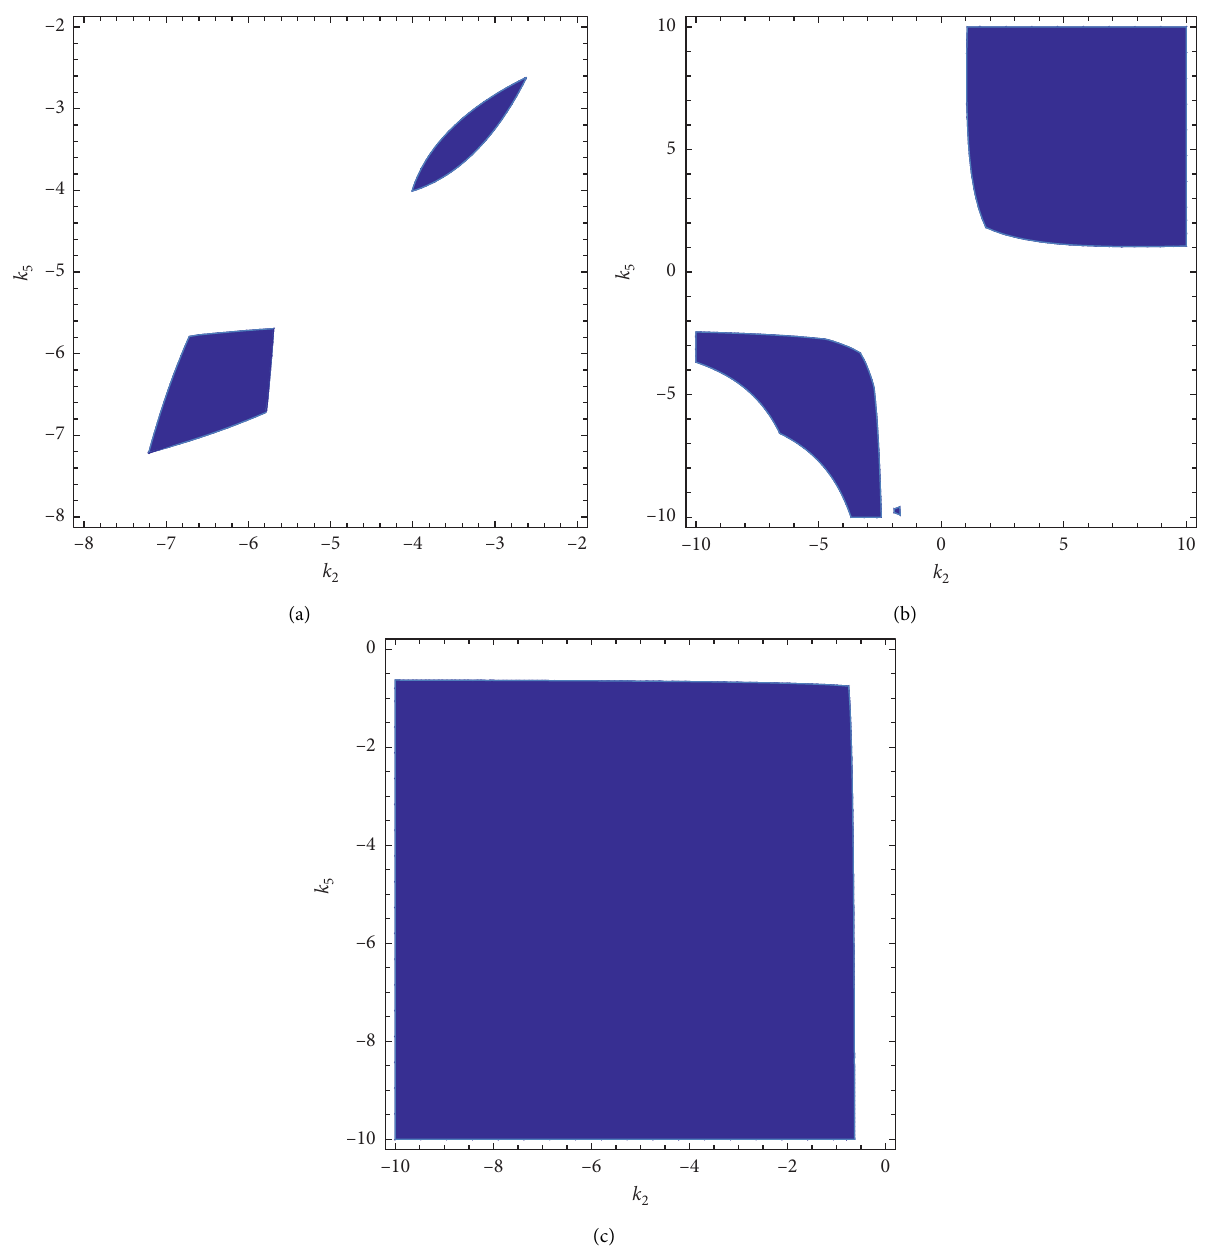
Figure 3: The parameters k and k control region. (a) The grazing bifurcation of ( 1/1 ) impact periodic motions. (b) The grazing bifurcation 2 5 of ( 1/2 ) impact periodic motions. (c) The codimension-two grazing bifurcation